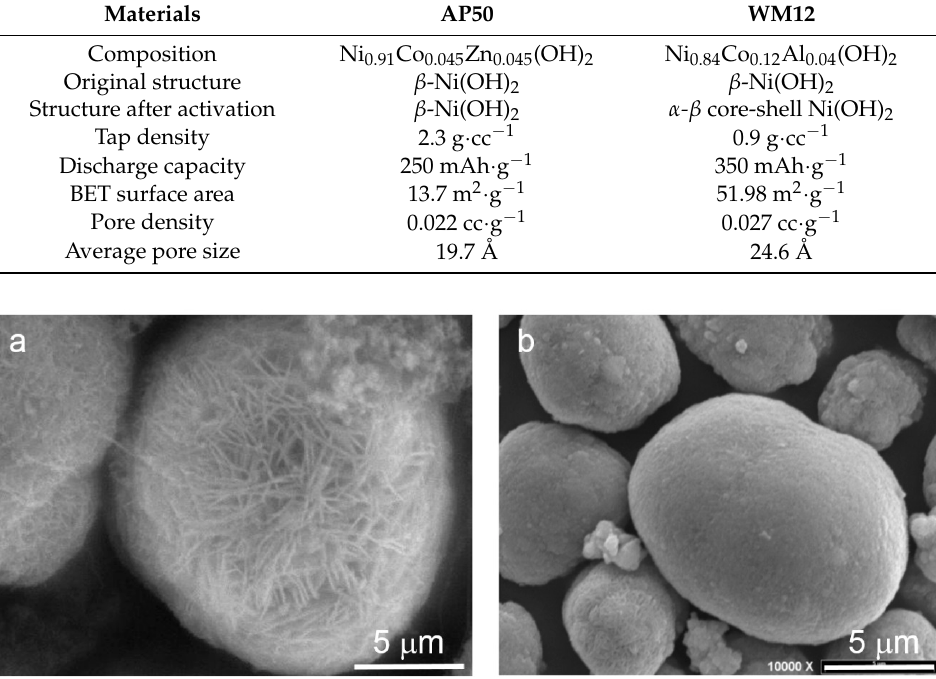
Figure 2. Scanning electron micrographs of ( a ) a heavily decorated WM12 surface and ( b ) a relatively smooth AP50 surface.